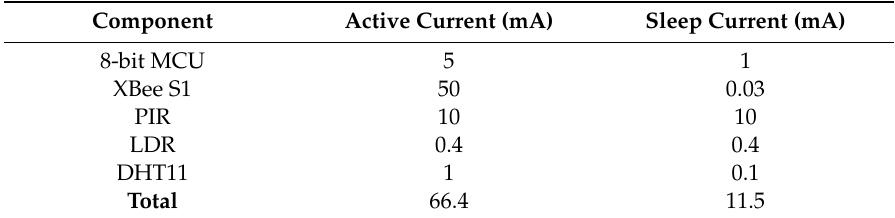
Table 1. Current consumption in the occupancy monitoring system.